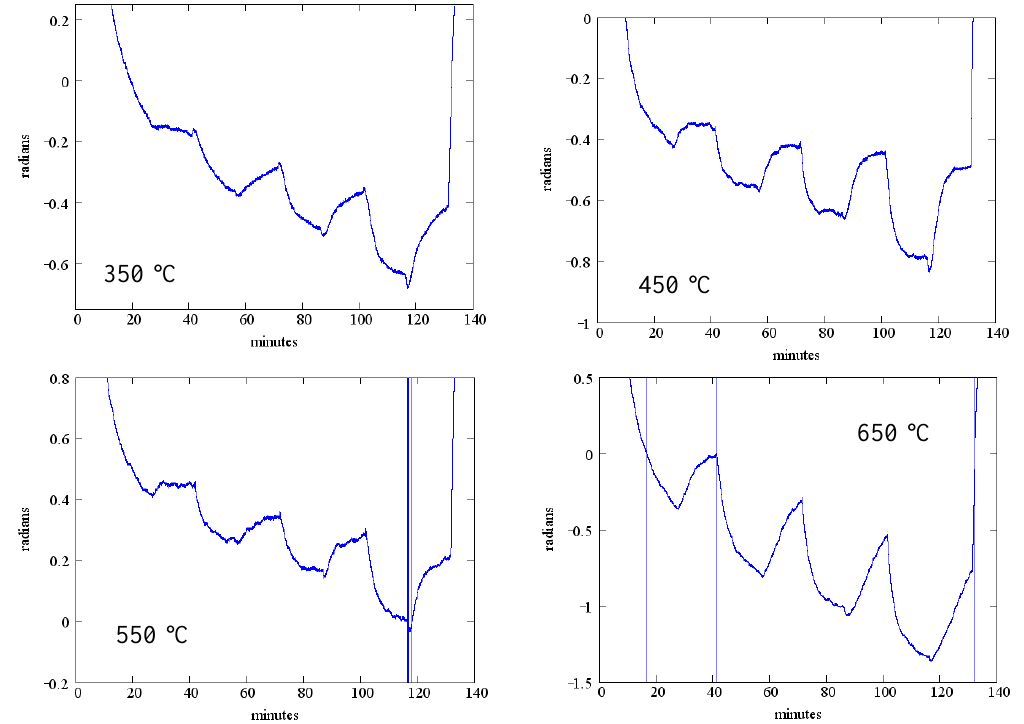
Figure 13. Measured phase change as a function of time for SAW device with 100 nm SnO sensing layer. Each plot shows the phase as a function of time when the oxygen 2 concentration is varied according to Figure